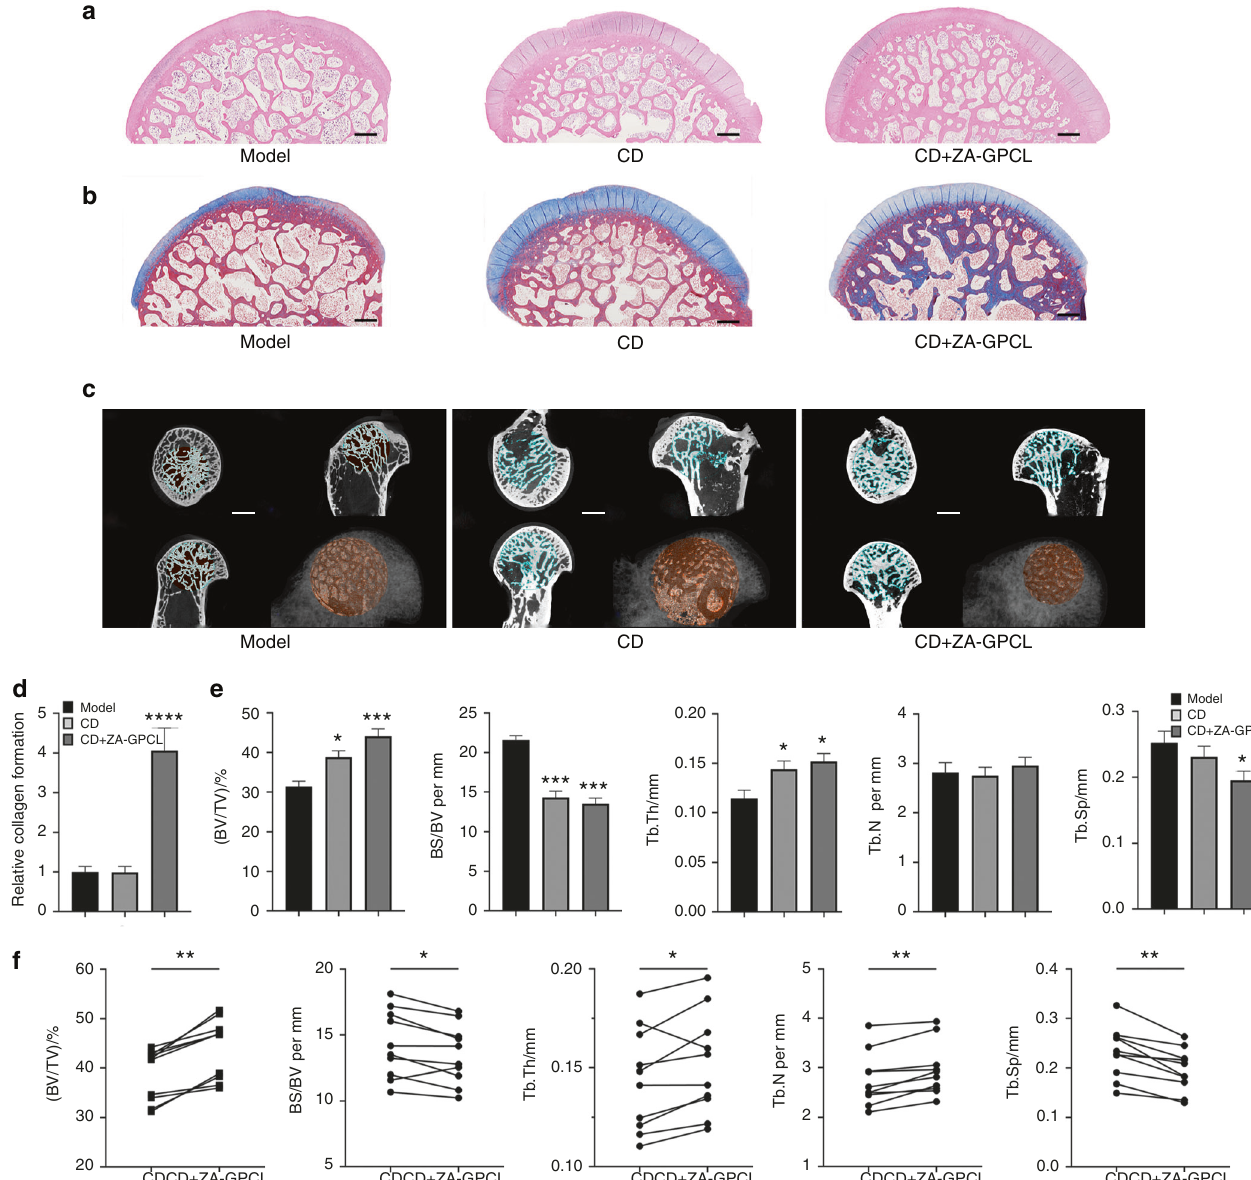
Fig. 5 General therapeutic effect in vivo. a HE-stained decalci fi ed femoral head sections. Scale bars: 500 μ m. b Masson ’ s staining of decalci fi ed femoral head sections. Scale bars: 500 μ m. c Sectional and 3D-reconstructed micro-CT images demonstrating the therapeutic effects on rabbit femoral heads. Scale bars: 1 mm. d Quanti fi cation of collagen formation in Masson ’ s-stained sections. e Quanti fi cation of BV/TV, BS/BV, Tb. N, Tb.Th, and Tb.Sp values of the femoral heads in the different treatment groups. f Paired analysis of BV/TV, BS/BV, Tb. N, Tb.Th, and Tb.Sp of the bilateral femoral heads of rabbits. All values represent the mean ± SEM ( n ≥